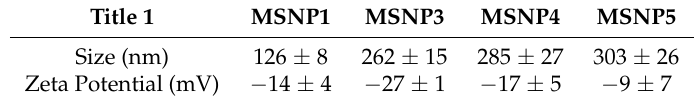
Table 1. Size and zeta potential of MSNP1, MSNP3, MSNP4 and MSNP5 nanoparticles.